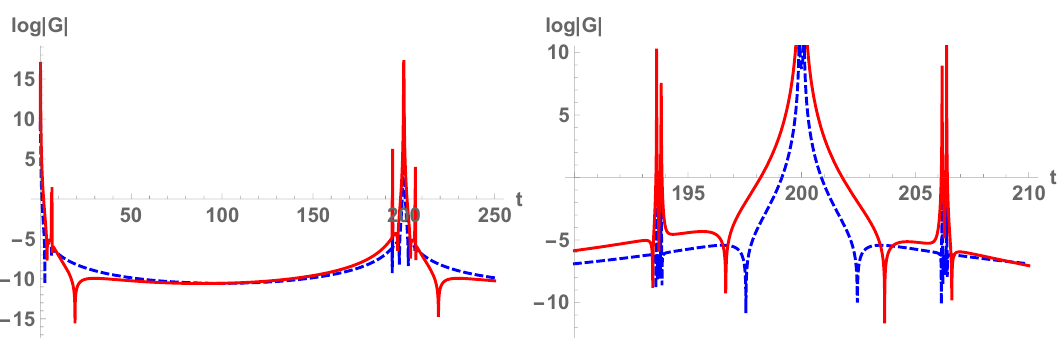
(∆ t, ∆ ϕ = 0 . 1) (in red) f WH (low) ,λ → λ 0 (∆ t, ∆ ϕ = 0 . 1) (in blue, dashed) f WH (low) ,λ → λ